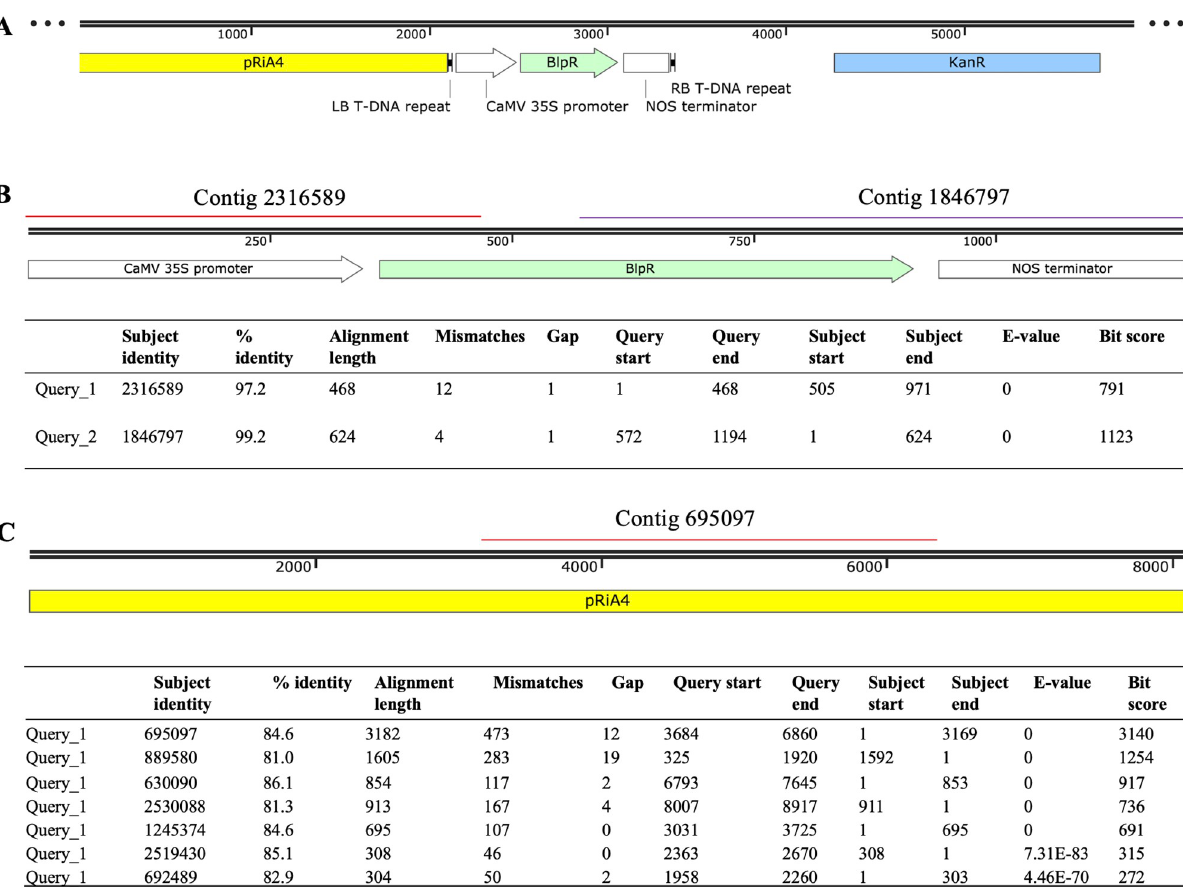
Fig 7. Stable integration of the transgenes confirmed by genome sequencing of a T 1 transgenic plant of the transgenic line #2. (A) Schematic representation of the binary vector pDHB321.1. (B) Detection of the bar in the T-DNA region. (C) Detection of the pRiA4 sequence in the backbone region of the